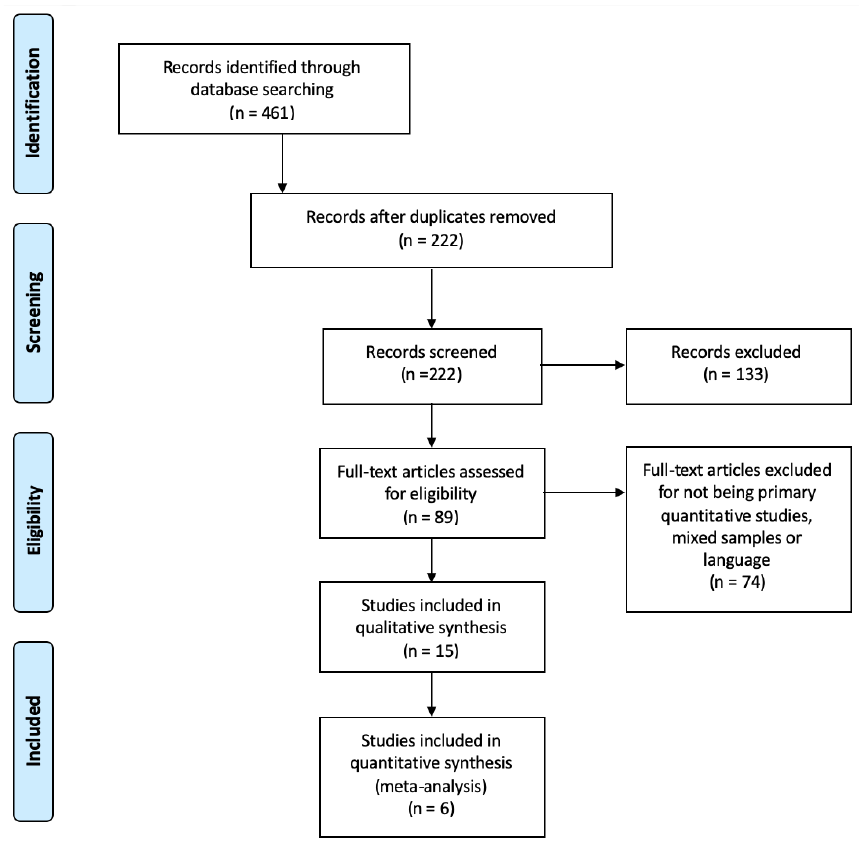
Figure 1. PRISMA flow diagram of studies selection.